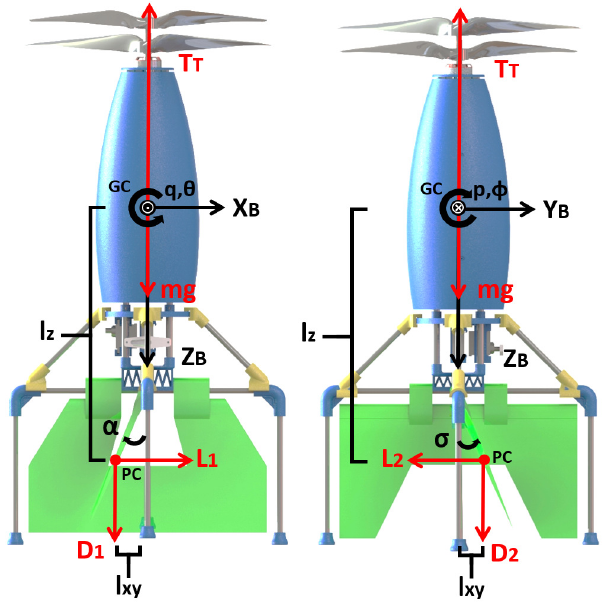
Figure 15. MCR UAV v3.0 forces.